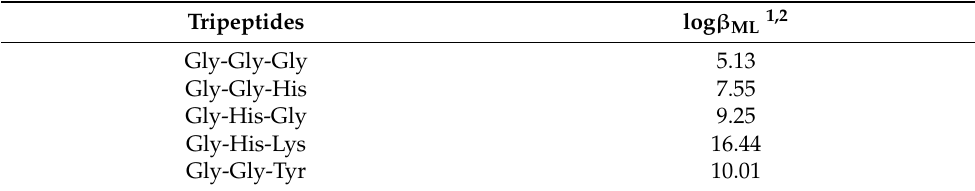
Table 3. ML 1 stability constant values for a selection of tripeptides 3